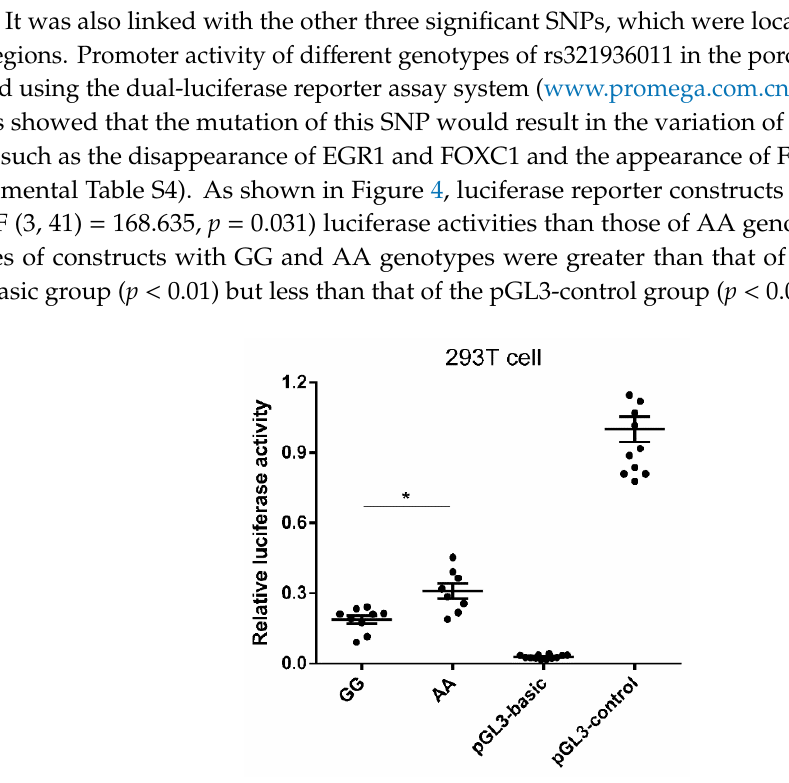
Figure 4. Luciferase reporter gene assays of porcine MAOA alleles containing rs321936011 ( − 30 G or